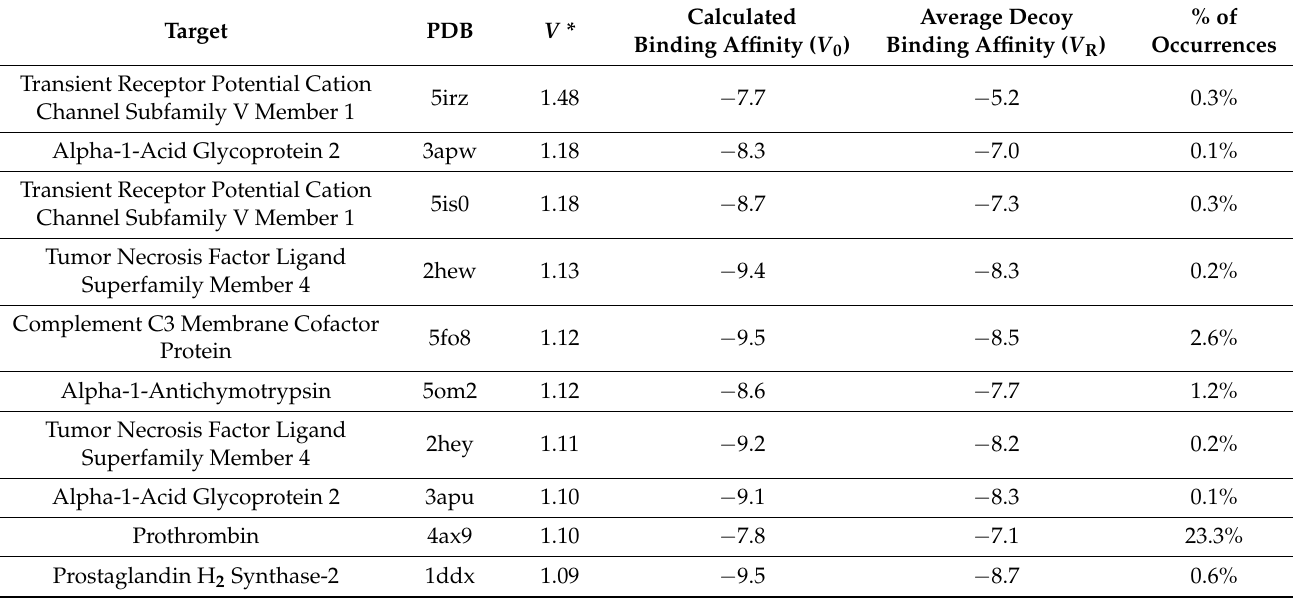
Table 1. IVS target ranking for 1 . The percentage of occurrences is calculated on the number of target structures with a V value above 0.9.